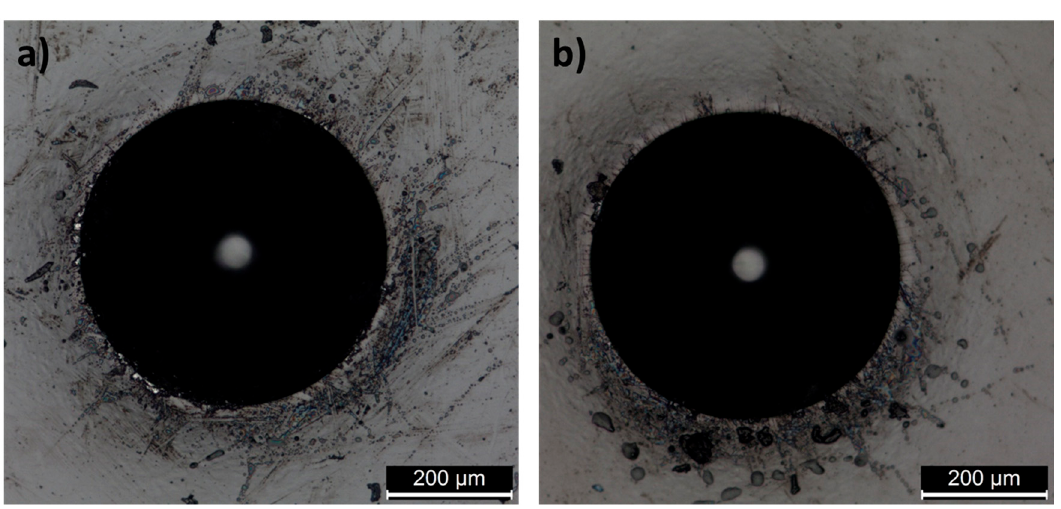
Figure 9. Aspects of the optical micrographs after the indentation Rockwell test impacts onto the ta-C DLC coating ( a ) and WC:C DLC coating ( b ).